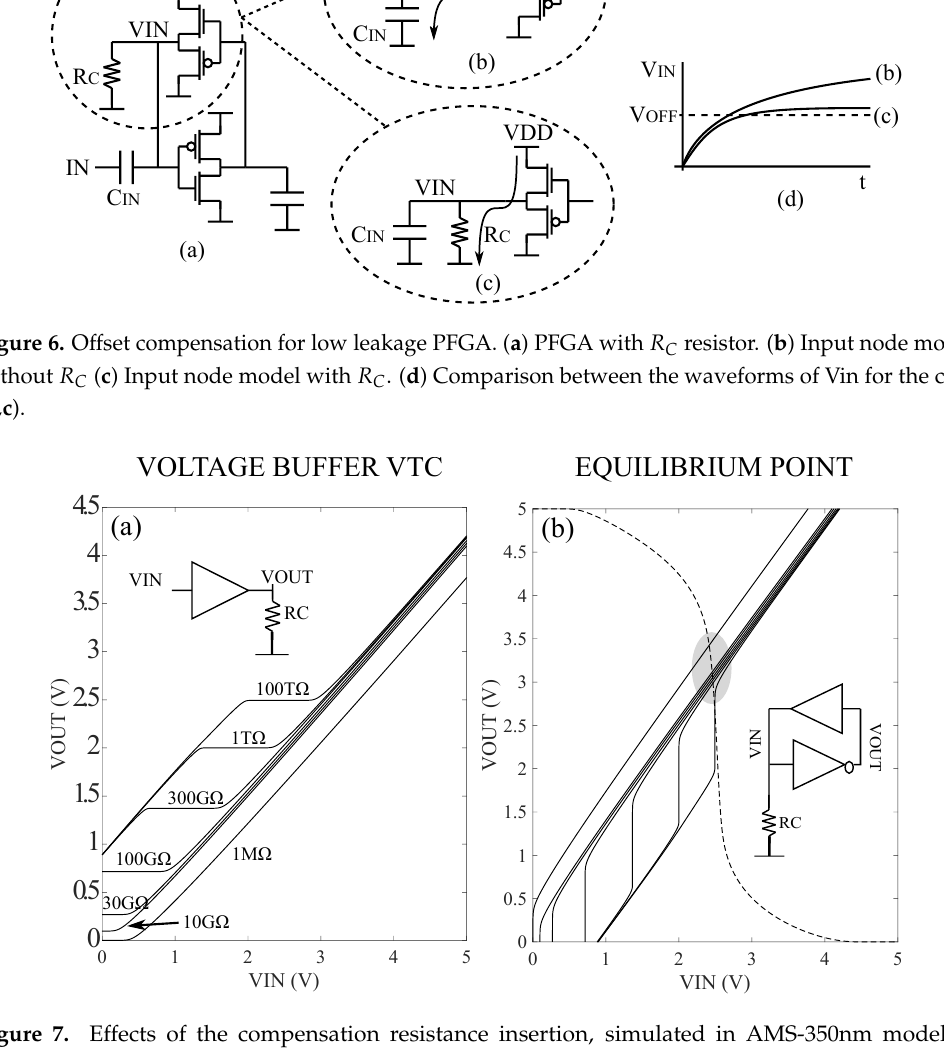
Figure 7. Effects of the compensation resistance insertion, simulated in AMS-350nm model at V DD = 5 V, ( W / L ) p = 2.3 µ m/350 nm, ( W / L ) n = 1 µ m/350 nm ( a ) Effects on the VTC curve of the voltage buffer. ( b ) Effects on the equilibrium point of the